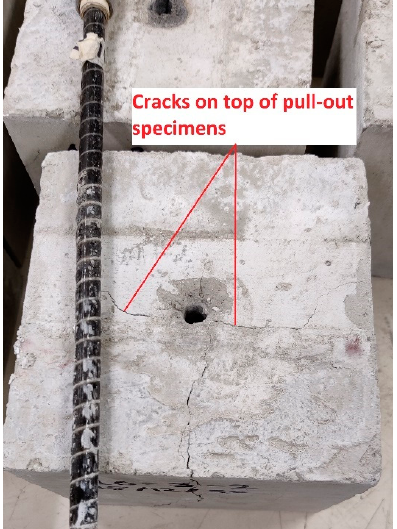
Figure 17 . Crack on the top surface of the 15 d b pull-out specimens.